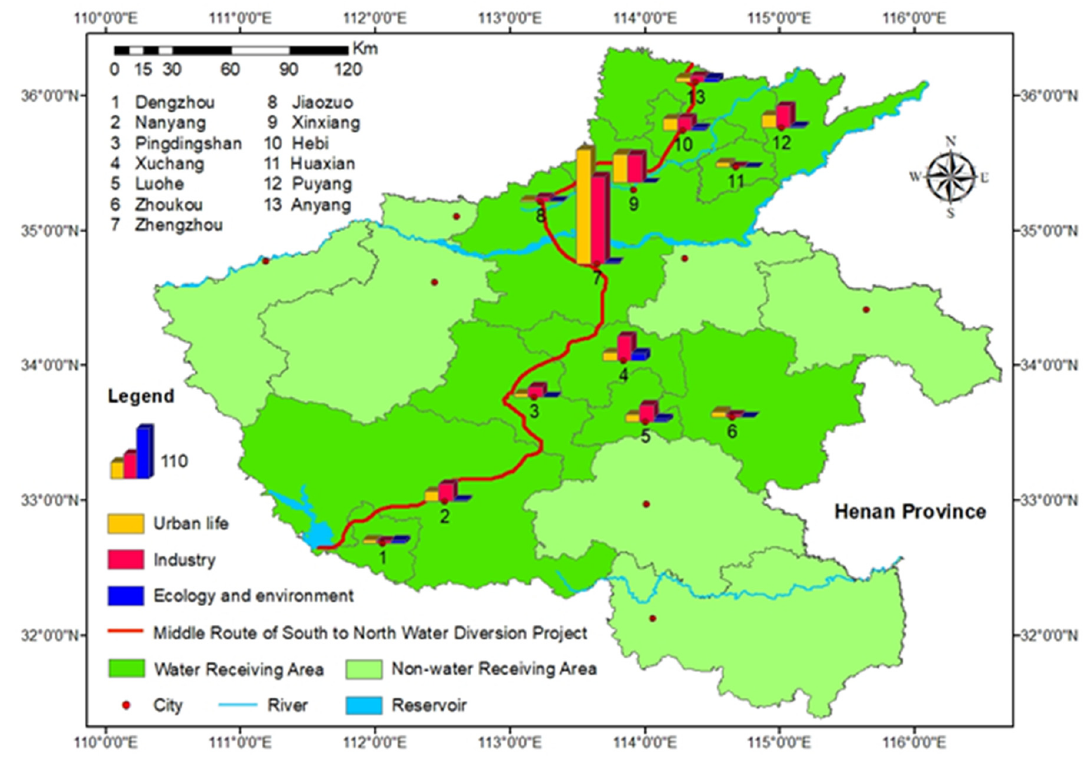
Figure 3. Study area.